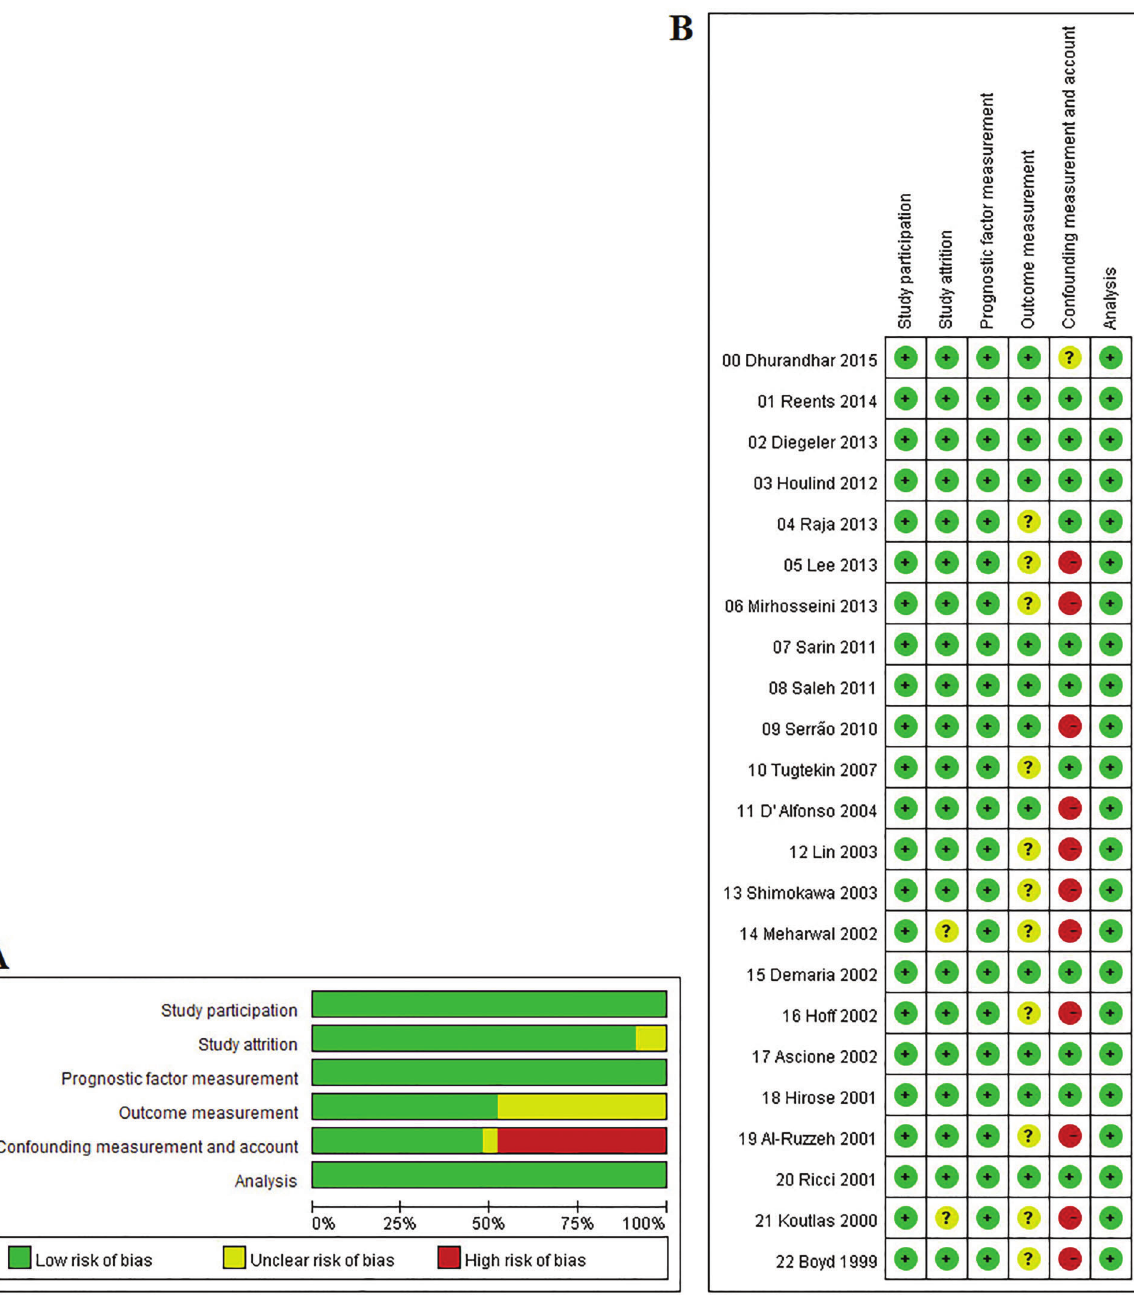
Figure 6. Quality assessment of included studies. A , Risk of bias assessment, and B , individual study